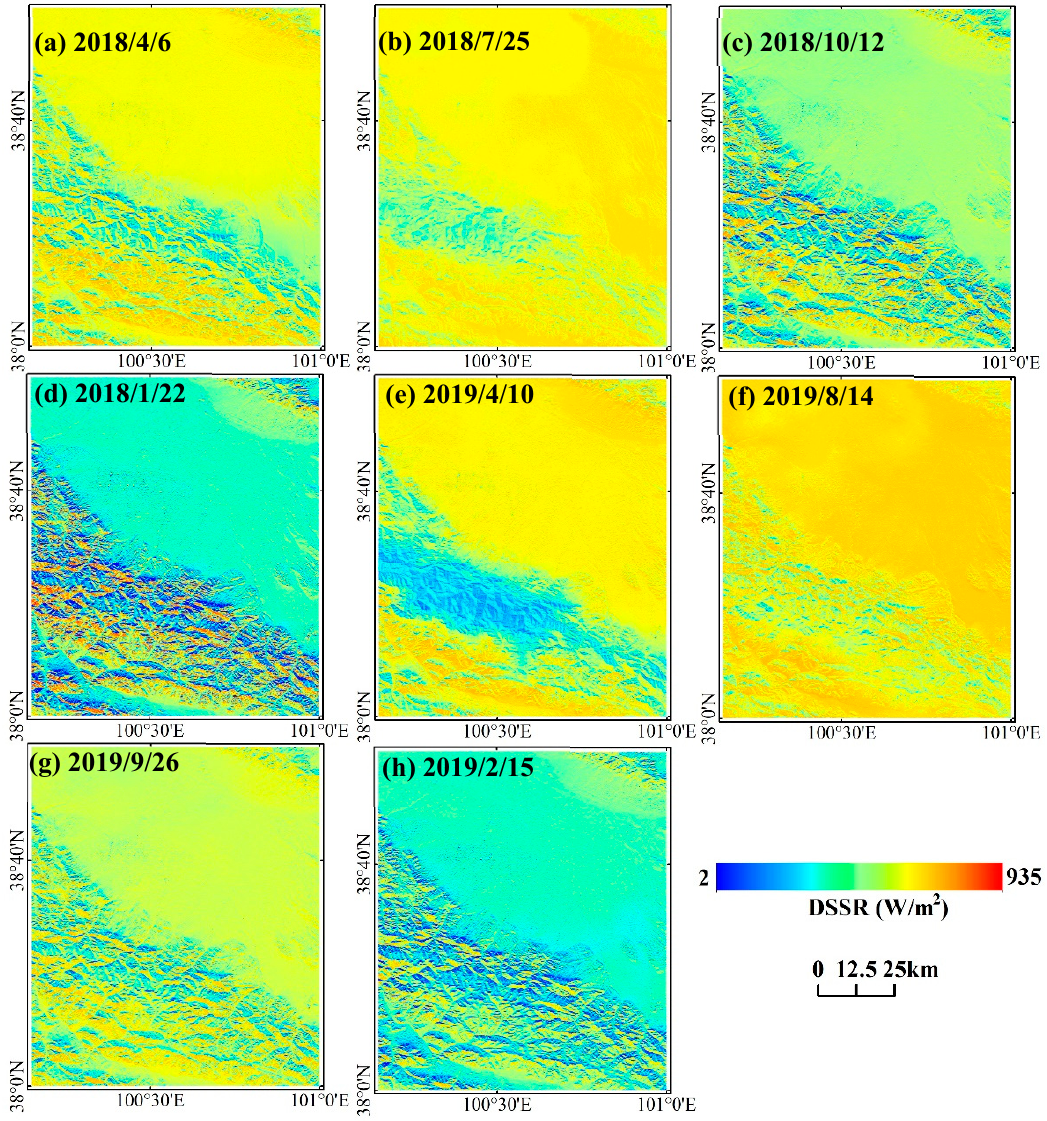
Figure 7. Spatial variations of daily average DSSR over 8 representative periods from 2018 to 2019.